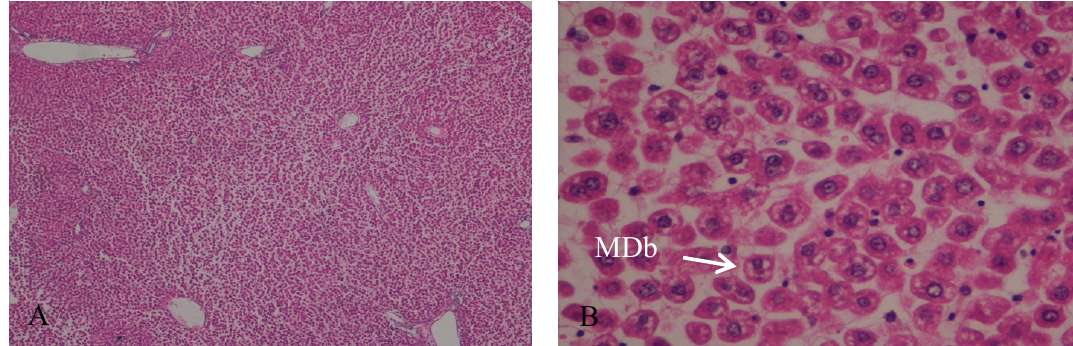
Figure 1. ( A ) Hepatic parenchyma with normal architecture. Moderate to severe disassociation of the hepatocytes, H&E, 40×; ( B ) Hepatocytes preserved the nucleus and intracellular organelles without signals of apoptosis or necrosis. Presence of Mallory-Denk bodies (MDb); H&E, 400×.